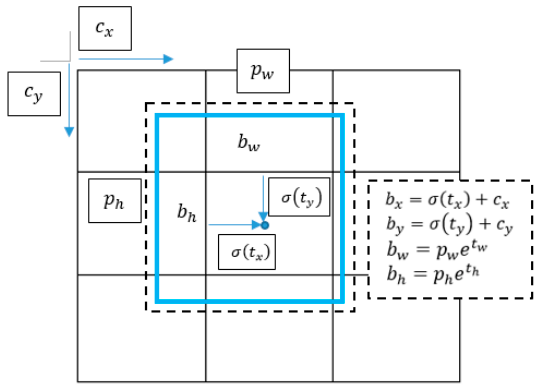
Figure 2. Bounding boxes with dimension priors and location prediction.